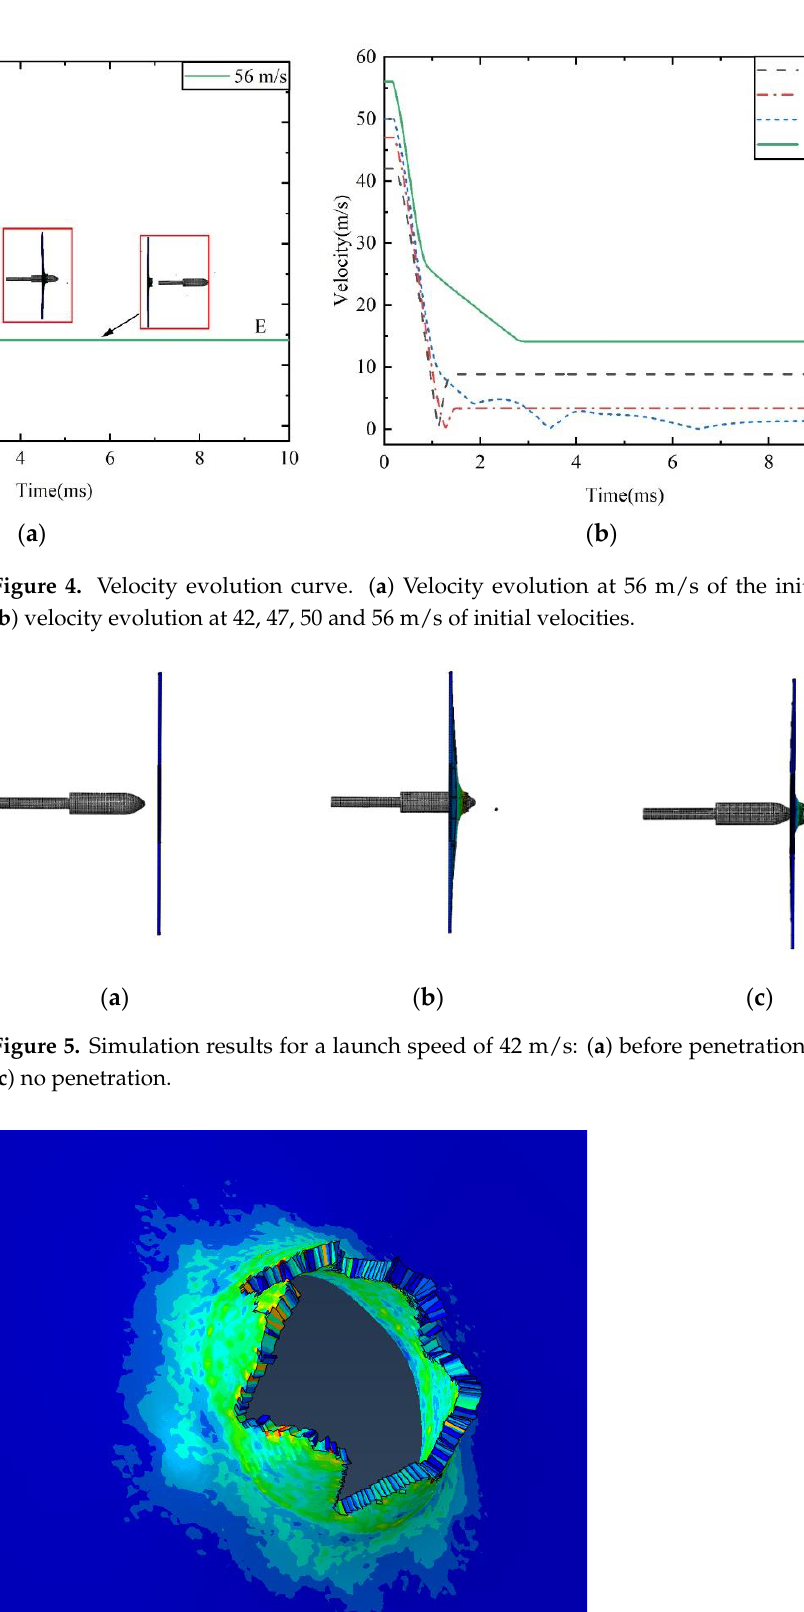
Figure 6. Details of target plate damage for a launch speed of 42 m/s.